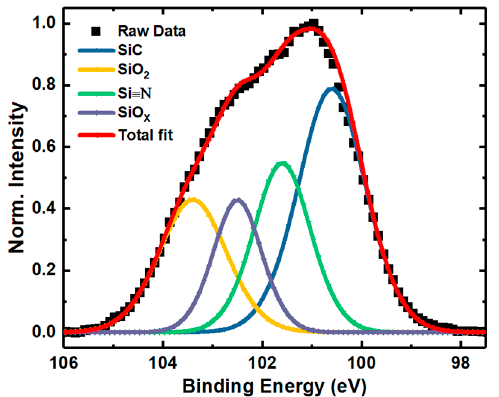
Figure 10. Si 2p core level XPS spectrum at the near interface of the samples with the irradiation dose of 5 × 10 13 p/cm 2 .